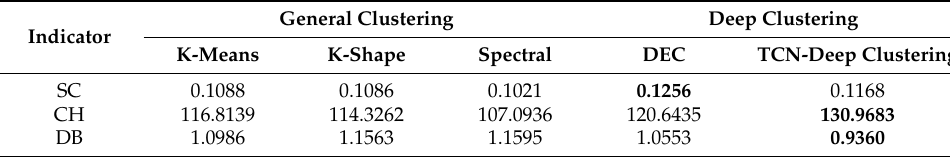
Table 3. S&P 500 Index clustering results.